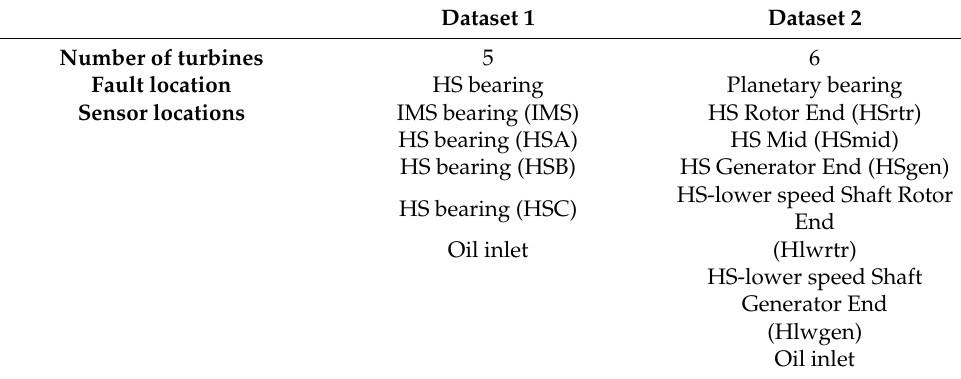
Table 1. Summary of dataset